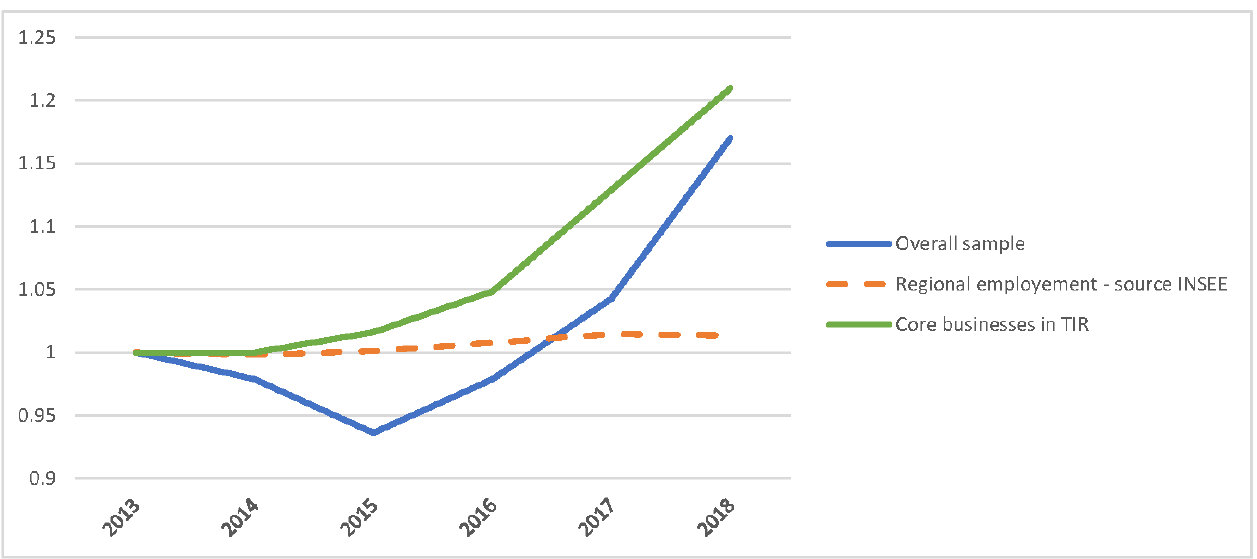
Figure 1. Evolution of employment growth related to TIR in Hauts-de-France between 2013 and 2018 (in base 100 in 2013).